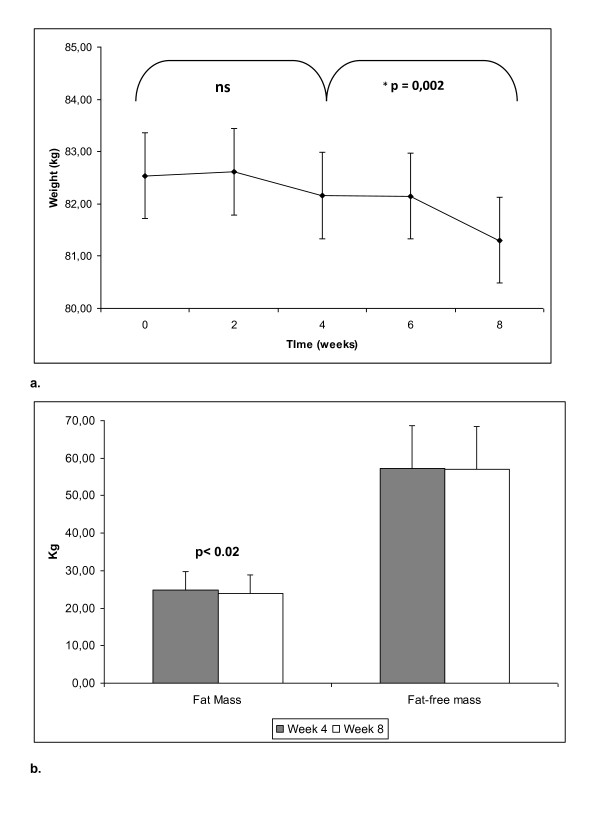
Anthropometrical changes during the study. The free living period corresponds to week 0 - week 4, while the nutritional intervention with 40-30-30 products corresponds to weeks 4-8. 1a: Body weight evolution. 1b: Fat mass Vs Fat-free mass.